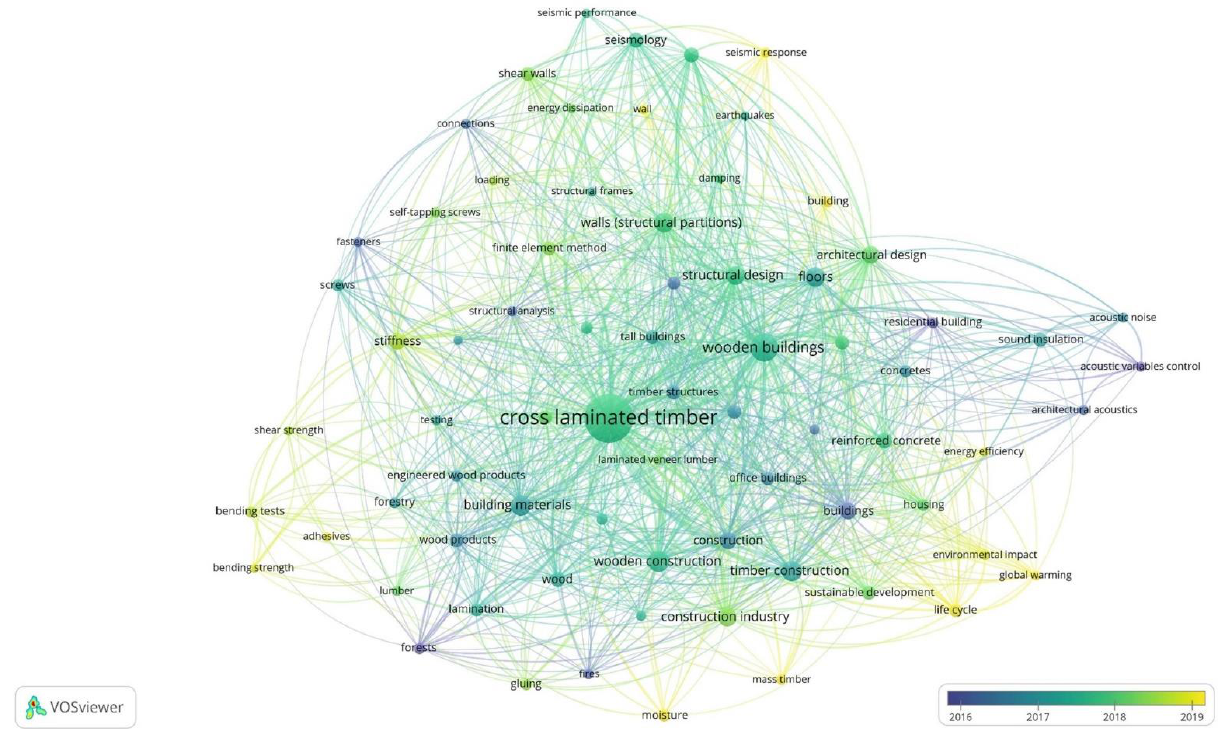
Figure 4. Time-based network of co-occurring keywords showing the evolution of nodes based on the average year for CLT in construction. Table 3. List of the top 10 most productive authors in the 2006–2022 time period for CLT in